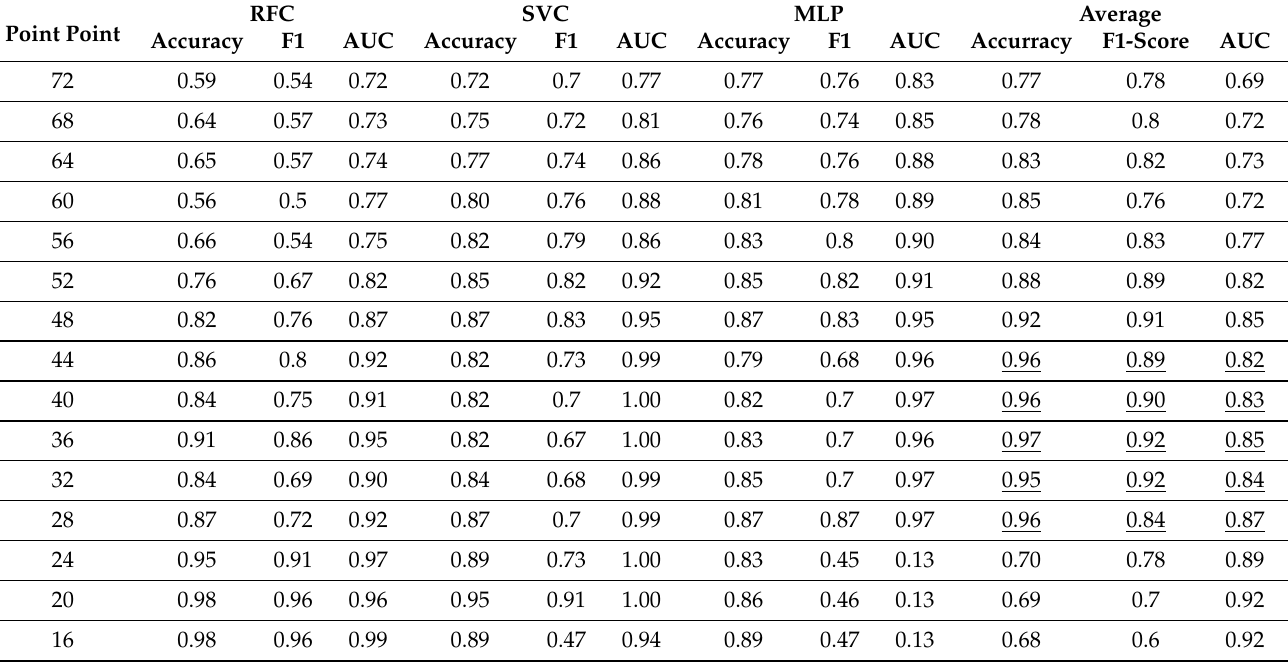
Table 3. Elbow point detection by evaluating different point values.